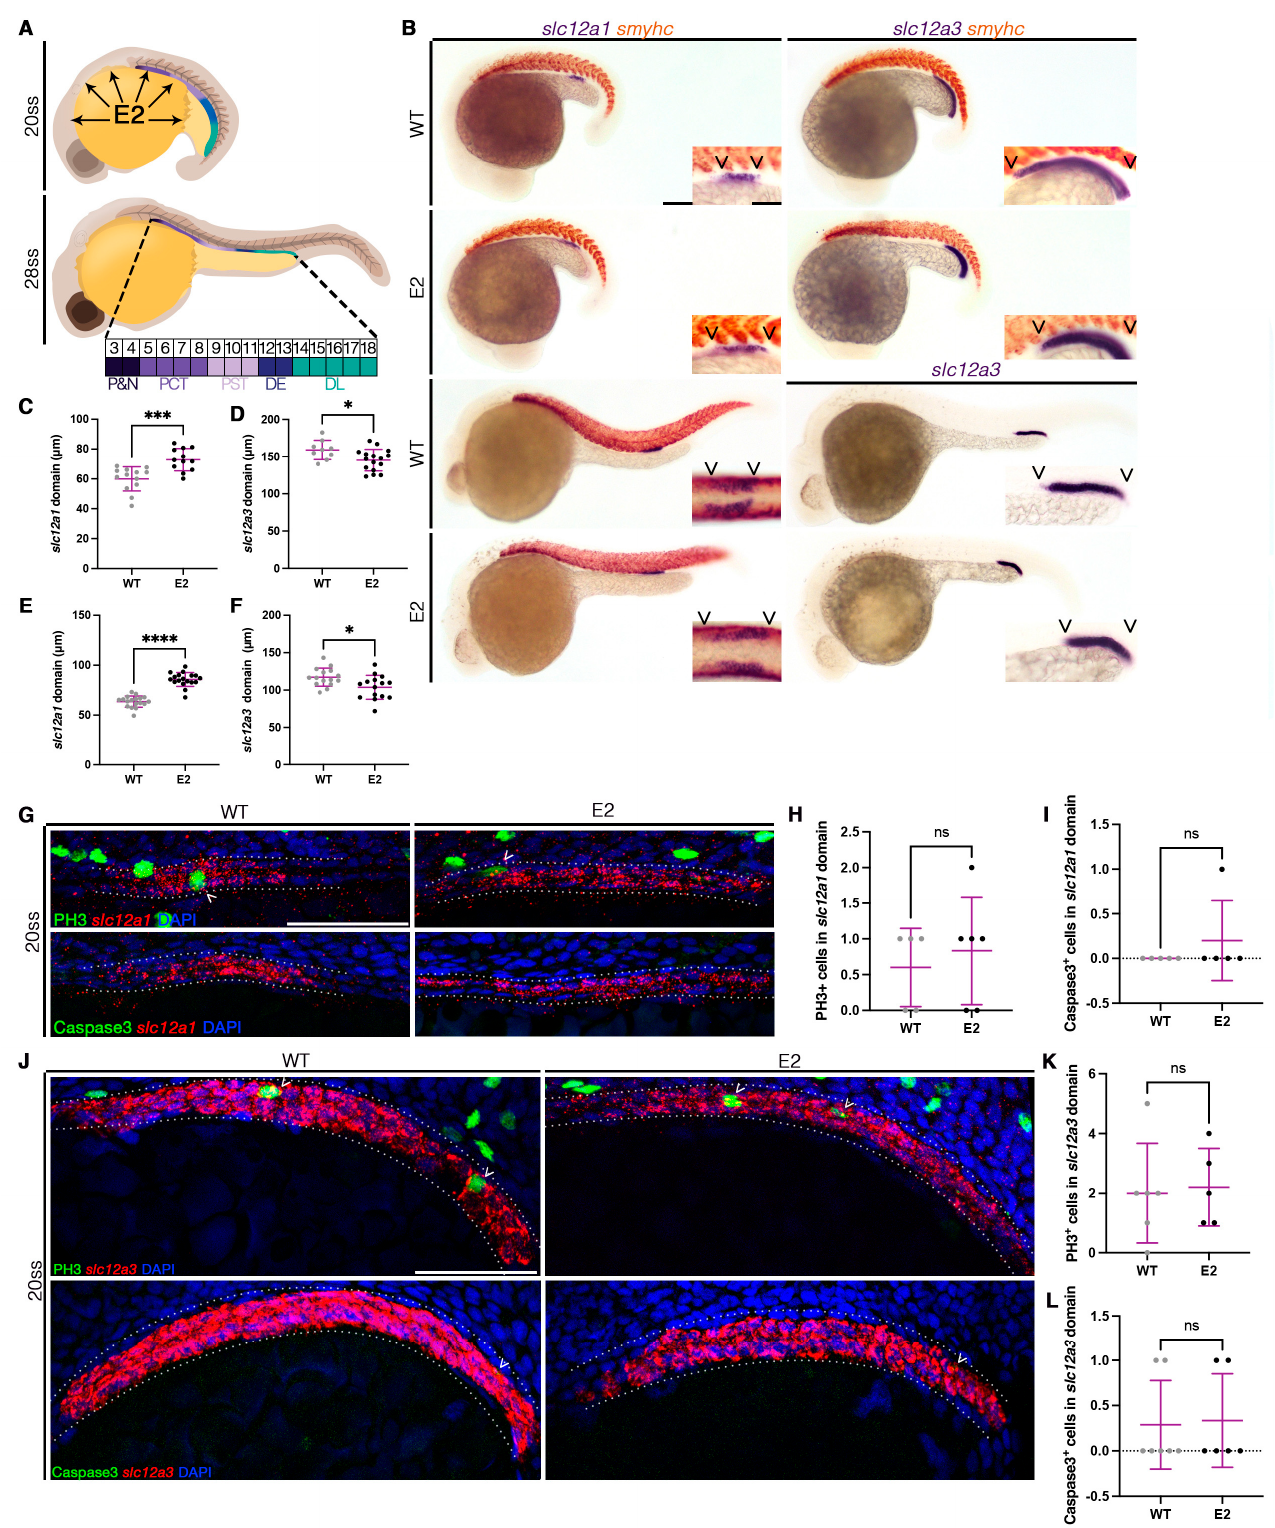
(Figure 1C) while the DL was shortened (Figure 1D). This phenotype persisted to the 28 ss when the nephron segments were initially patterned (Figure 1B,E,F).